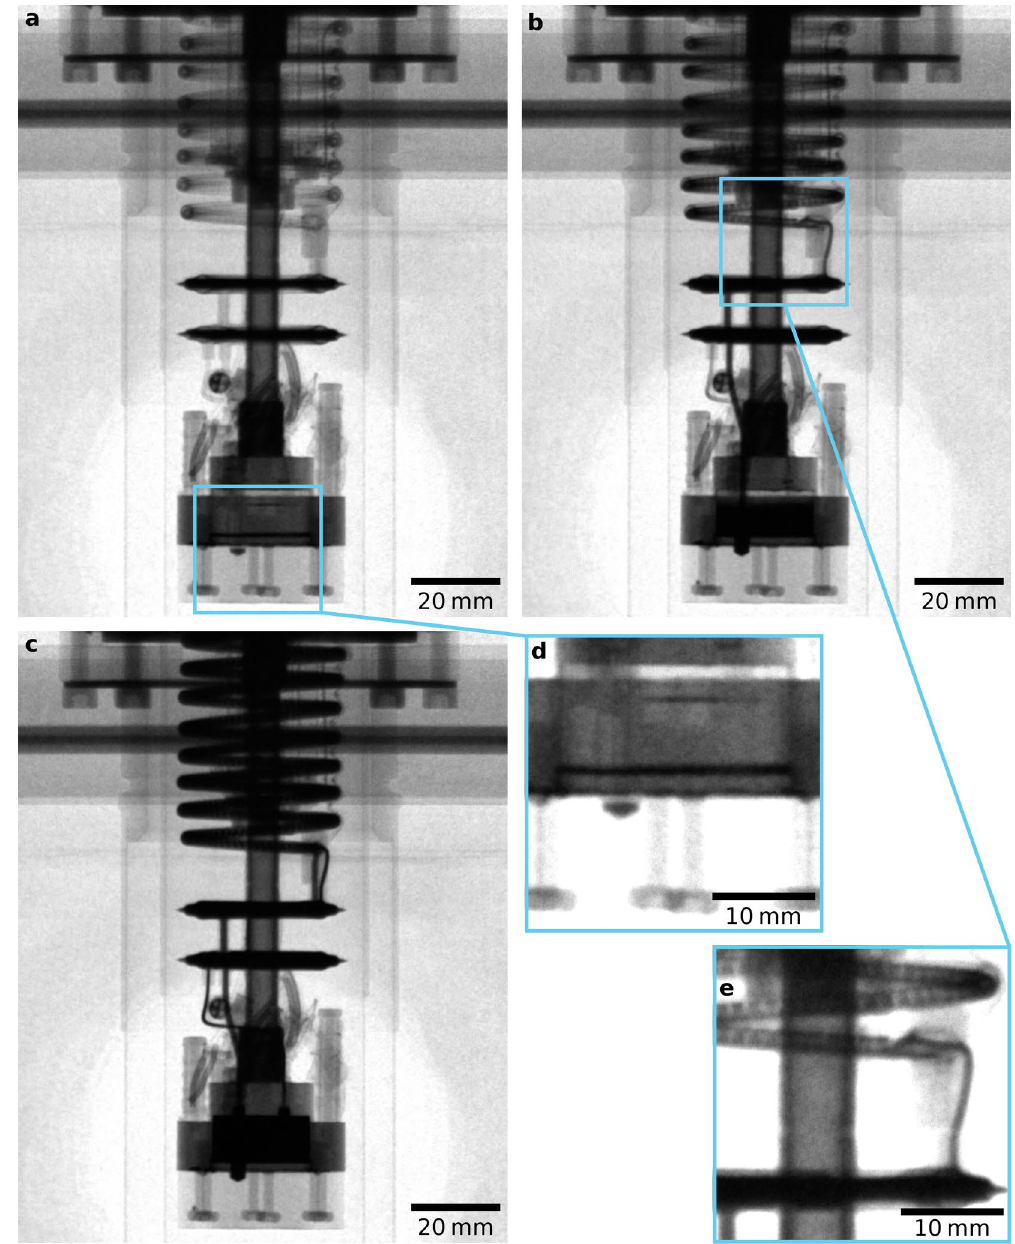
Figure 2. Neutron images of the DR during mixture condensation. ( a – c ) The DR progressing through the condensation process. Note the small layers of mixture in the still tube pickup, at the MC base, and on top of the displacer in the inset ( d ), which is a zoomed-in and contrast-adjusted region of ( a ), captured shortly after the initiation of condensation. Panel ( e ) is a zoomed-in and contrast-adjusted region of ( b ) showing